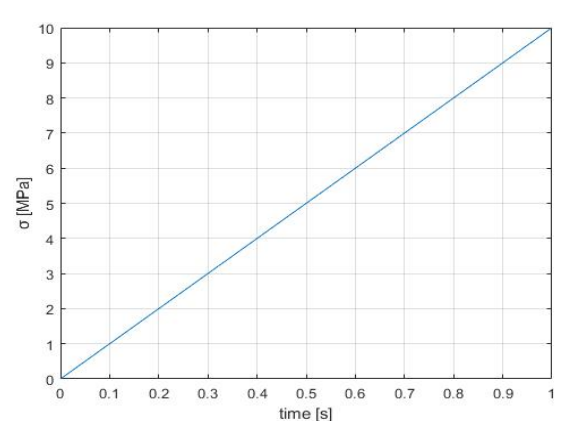
Figure 17. Graph of the time course of the setpoint.